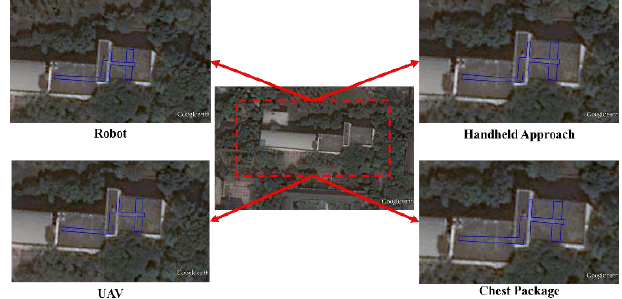
Figure 10. The generated map using different platforms after map rectification on Google